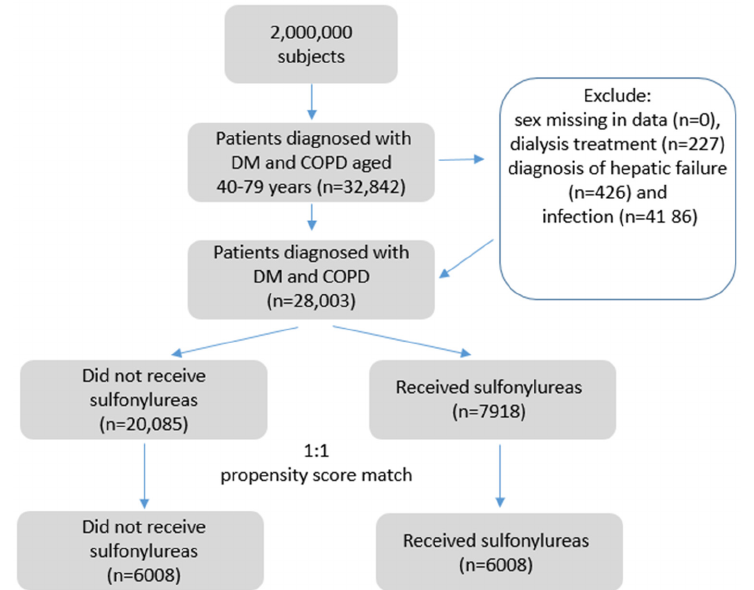
Figure 2. The flowchart of patient identification.